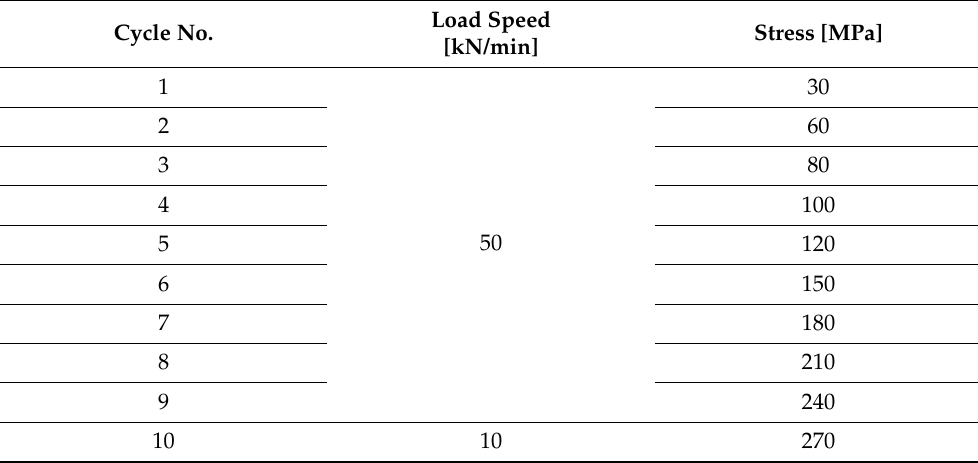
Table 1. Parameters for RPL tests.